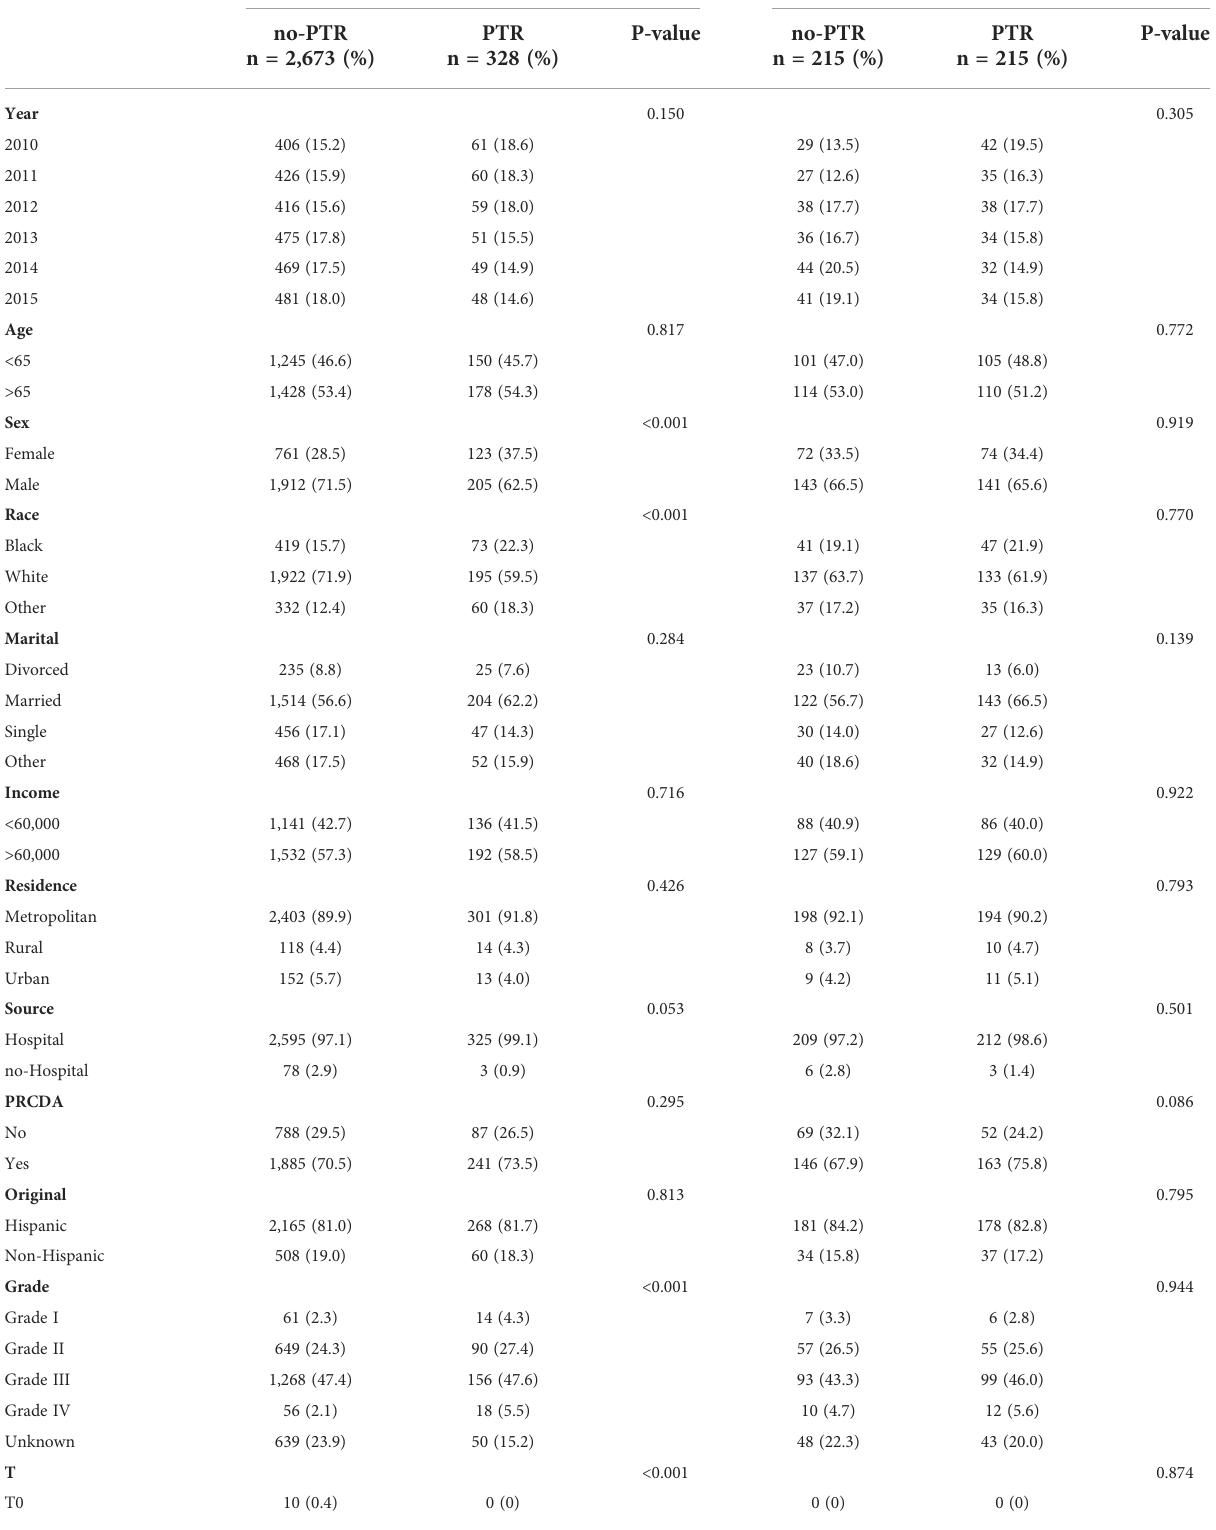
TABLE 1 Baseline characteristics of the selected patients before and after propensity score